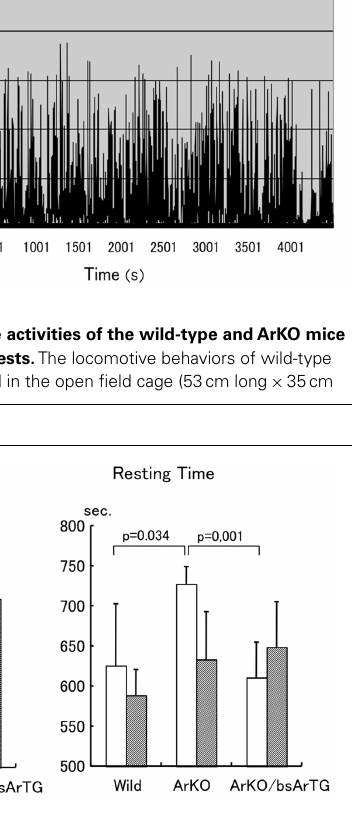
FIGURE 6 | Impairment and restoration of locomotive activities of wild-type,ArKO, andArKO/bsArTG mice. The travel distance and resting time during a 15-min open field test were analyzed from video-recorded locomotor activities of males (hatched bars) and females (open bars) of wild-type ( n = 9), ArKO ( n = 11), and ArKO/bsArTG ( n = 9) mice aged 14–16weeks. behaviors (Bakker et al., 2002a,b; Aste et al., 2003; Matsumoto